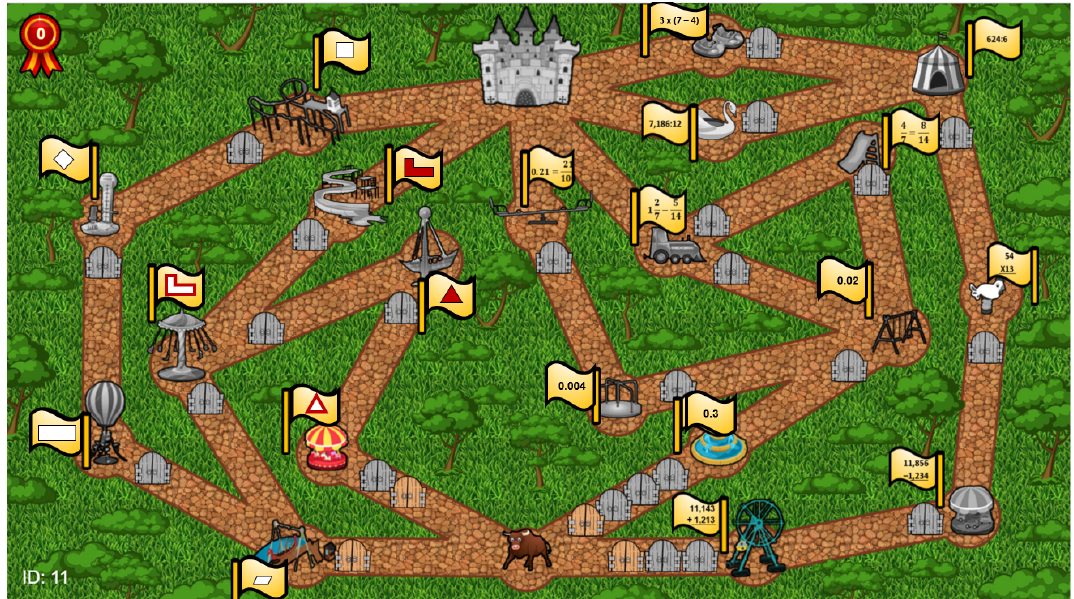
Figure 2. SWOPP (Supervisor-Worker Problem with Partially Overlapping goals)-induced map for carnival game for a given student in the study. The intended goal of the teacher for the student to practice the properties of quadrilaterals (leftmost path). The cost of the first skill in all other paths was increased by the